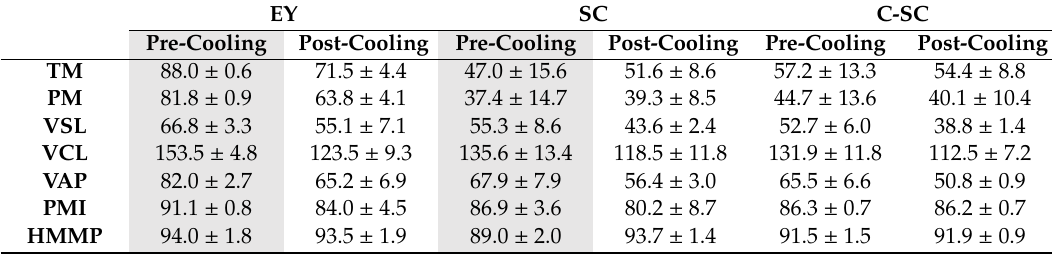
Table 1. Donkey epididymal semen parameters were assessed immediately after semen harvesting (pre-cooling)oraftercoolingfor24h(post-cooling). Harvestingwasperformedwithin1hpost-castration ( n = 4 pairs). Each epididymal pair was submitted to retrograde flushing with a freezing egg yolk-based extender (EY) or a cooling extender based on sodium caseinate cholesterol-loaded cyclodextrin (SC). Thereafter, the semen extended in EY was cooled for 24 h, whereas the semen extended in SC was cooled for 24 h, or cushion-centrifuged, re-extended with SC, and then cooled for 24 h (C-SC). Data are expressed as mean ± SEM. EY SC C-SC Pre-Cooling Post-Cooling Pre-Cooling Post-Cooling Pre-Cooling Post-Cooling